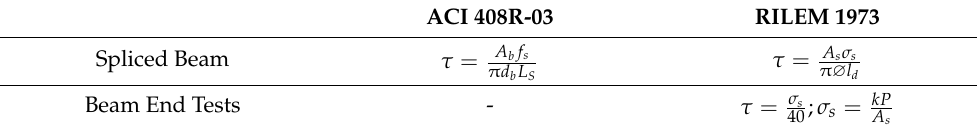
Table 2. Bond strength by spliced beam/beam end test method [16,30,36–38].